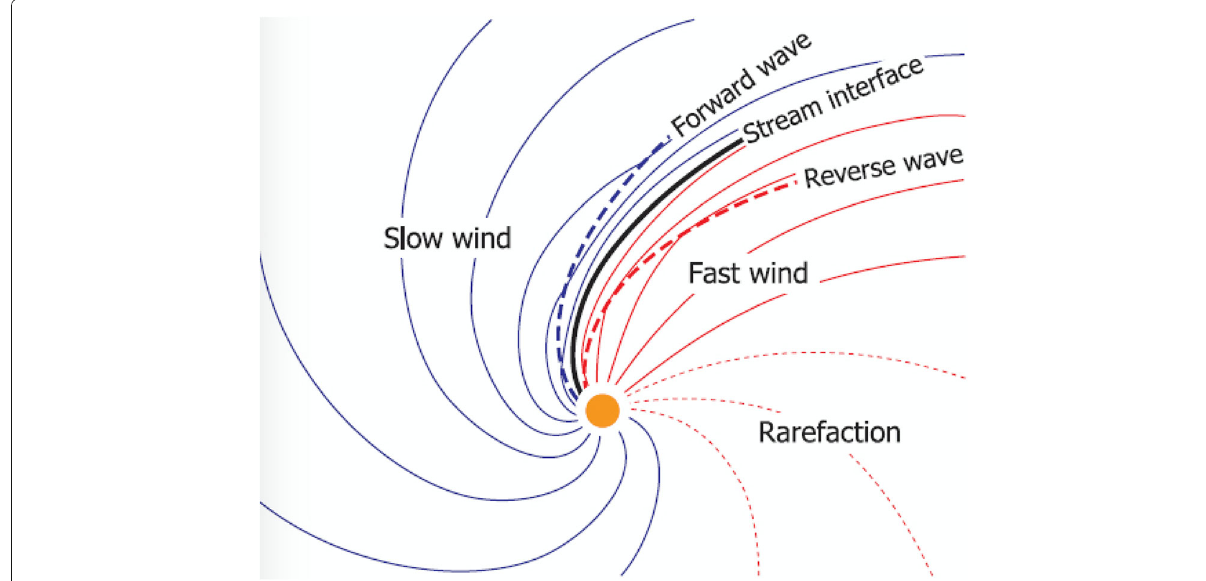
Fig. 2 A conceptual schematic of a CIR (adapted from Owens and Forsyth (2013)). Forward (reverse) shock is shown as a dashed blue (red)